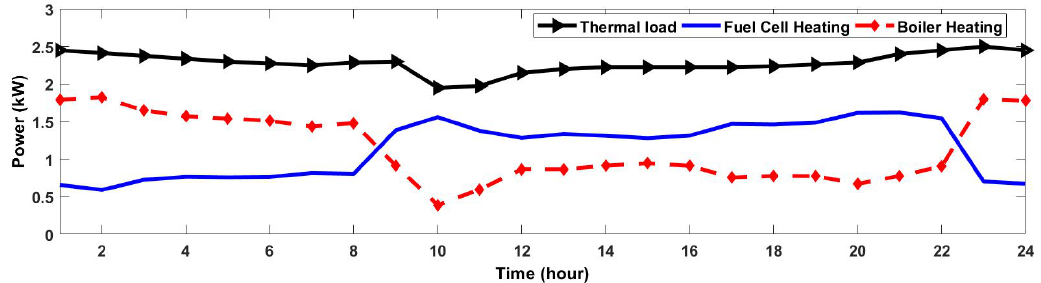
Figure 12. Case 6: Thermal heating.